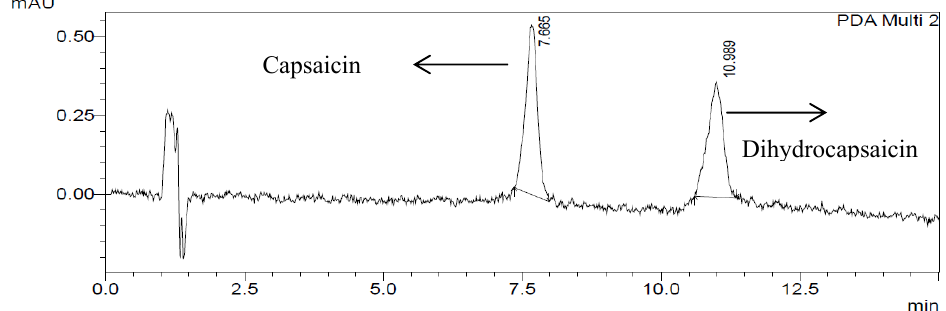
Figure 2. Chromatogram of capsaicin and dihydrocapsaicin (0.50 µg/g) using UV detection at 280